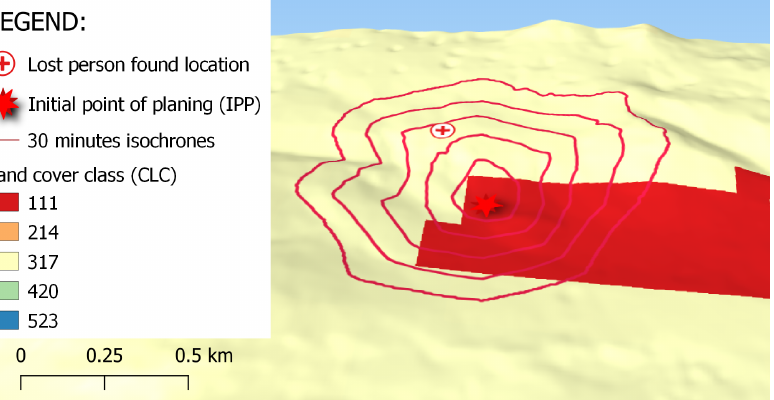
Figure 7. Result of simulation with isochrones showing maximal reached area in every half an hour. IPP is taken from archive of SAR activities, and location where subject is found is denoted with red cross.